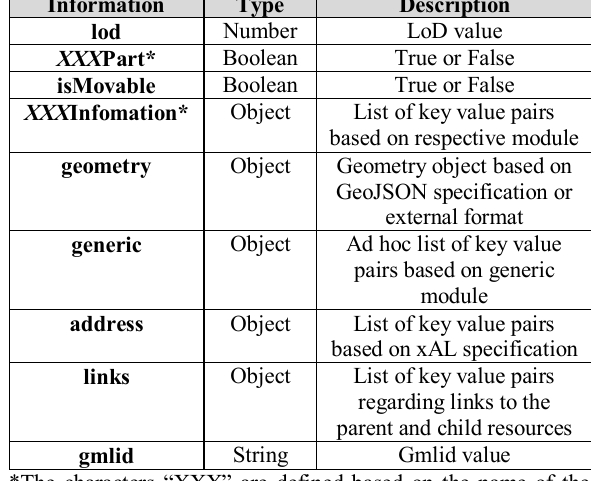
Table 2. Available information of the main resources